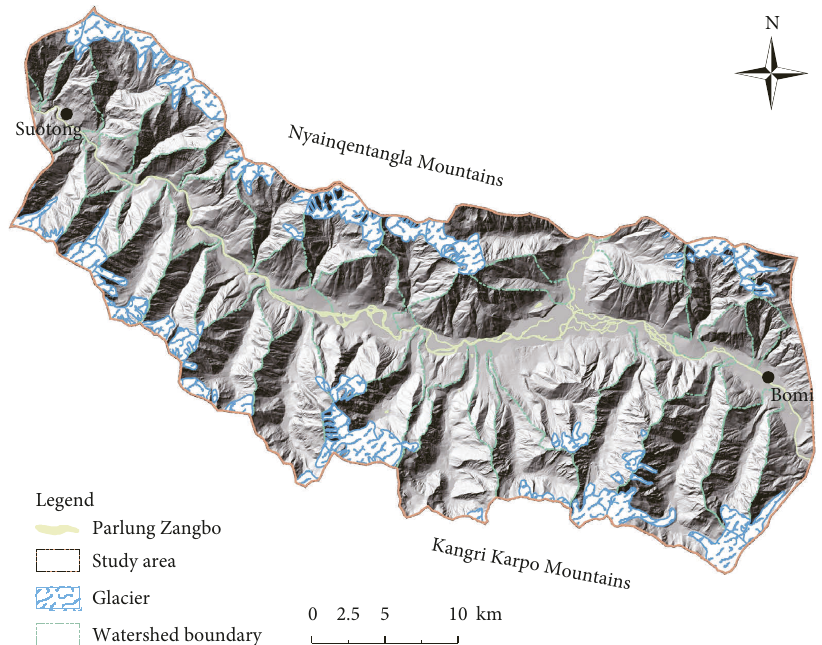
Figure 2: Glacier distribution and overall form of gullies along two banks between Bomi and Suotong in Figure 1 (glacier data are from [15]).